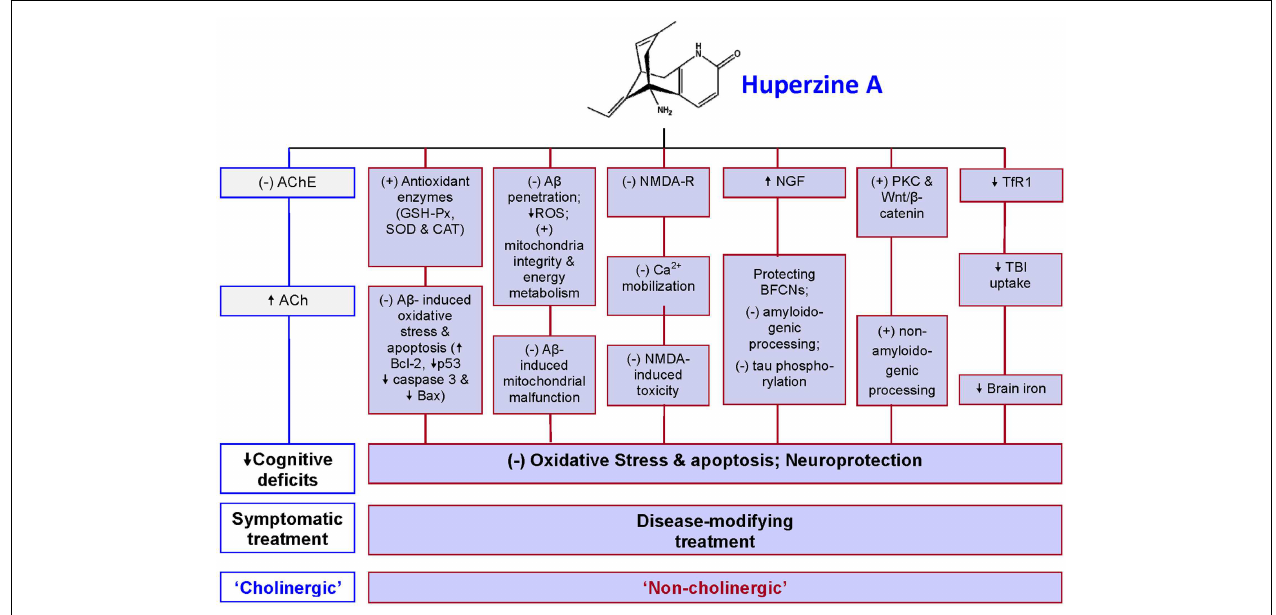
FIGURE 1 |A summary of pharmacological mechanisms of huperzineA (HupA) in the treatment ofAlzheimer’s disease (AD) . In addition to acting as an acetylcholinesterase (AchE) inhibitor, HupA has non-cholinergic roles in the treatment of AD to protect neurons and other brain cells from oxidative stress damage and apoptosis. It has been demonstrated that HupA has the ability: (1) to protect neurons against A β -induced oxidative injury and apoptosis by enhancing the activities of antioxidant enzymes including glutathione peroxidase (GSH-Px), superoxide dismutase (SOD), and catalase (CAT), attenuating the A β -induced increase in caspase-3 activity, and inhibiting A β -induced apoptosis by reversing the down-regulation of the expression of Bcl-2 and the up-regulation of Bax and p53 expressions; (2) to ameliorate mitochondrial malfunction in AD brain by preventing A β -penetration into the mitochondria, suppressing ROS production, and improving mitochondrial integrity and energy metabolism, thus minimizing A β -induced mitochondrial malfunction; (3) to act as antagonist of the